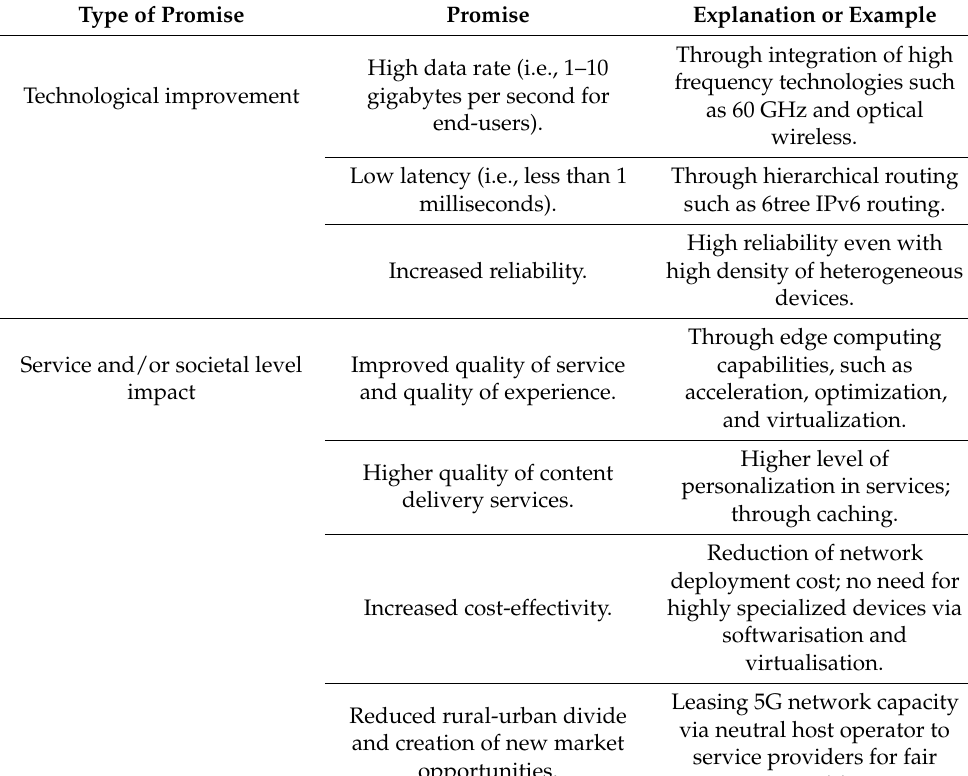
Table 1. Anticipated offerings of 5G network